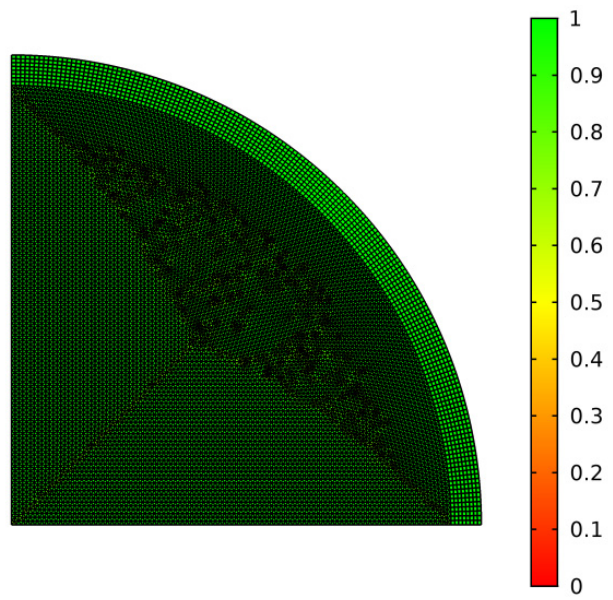
Figure 13. Grid structure of the model.